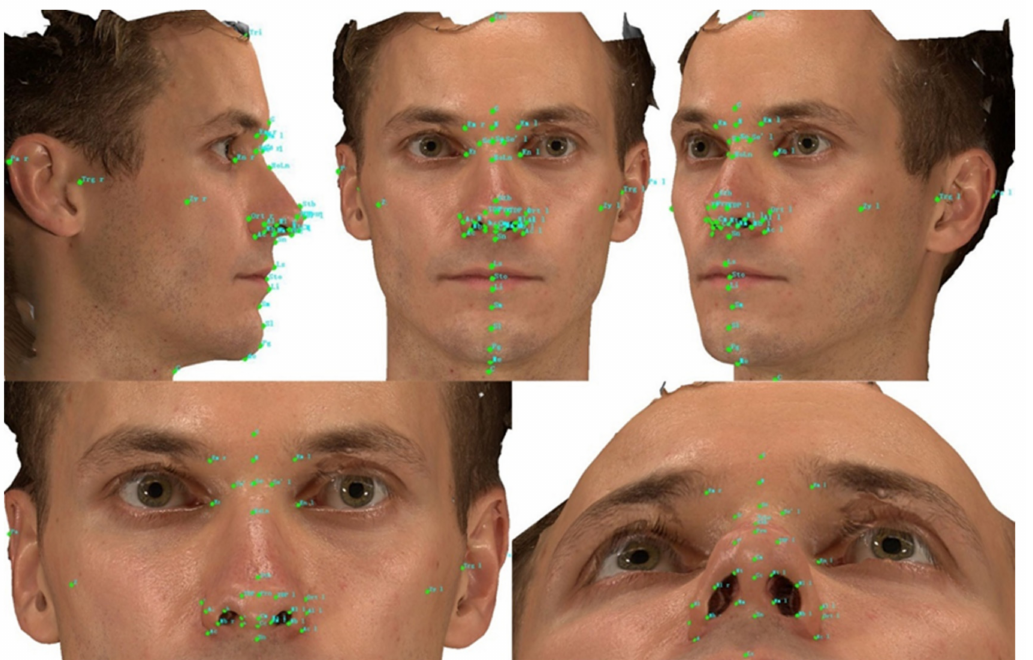
Figure 1. Illustration of the landmarks used in this study (holistic view and local